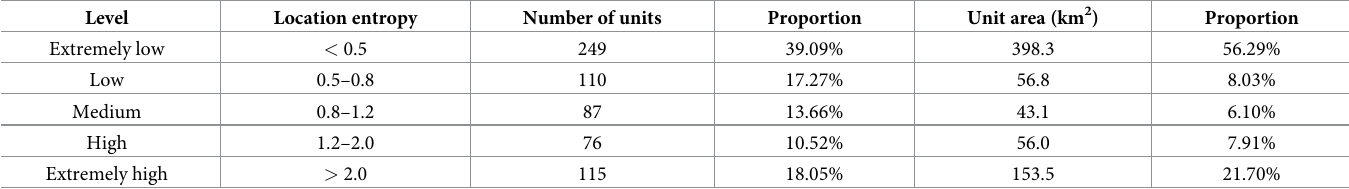
Table 5. The number and proportion of spatial units of location